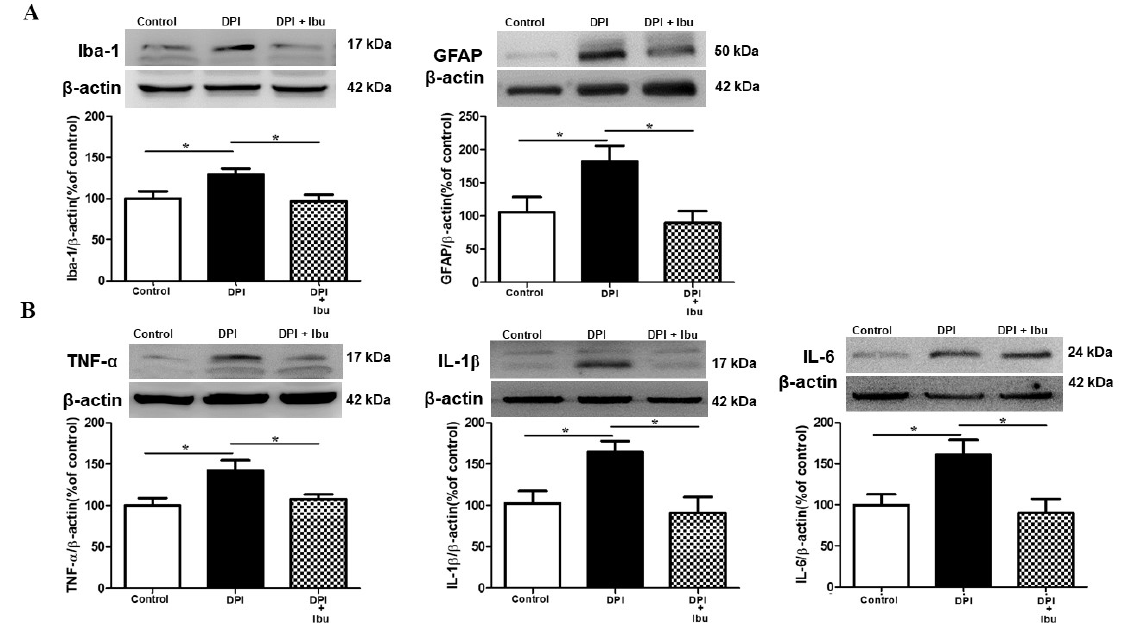
Figure 6. Ibuprofen restrains DPI-induced changes in glial and cytokine expression in the Vc. ( A , B ) Ibuprofen treatment inhibited high levels of microglial and astrocytes markers (Iba1 and GFAP, respectively), as well as reduced the production of pro-inflammatory cytokine TNF- α , IL-1 β , and IL-6 expression following DPI. Between-group comparisons for each group were performed by ANOVA, followed by Dunnett’s test (* p < 0.05, versus DPI group; n = 6 in each